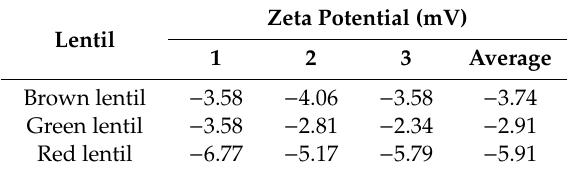
Table 3. Zeta potential of the lentil extracts.